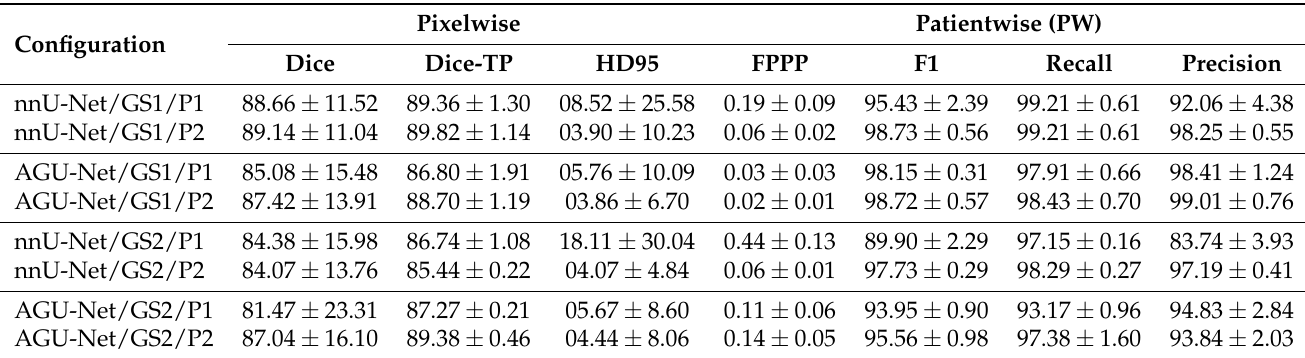
Table 5. Segmentation performances obtained with the different architectures and preprocessing schemes, averaged from the three models of the custom validation protocol, over the two data